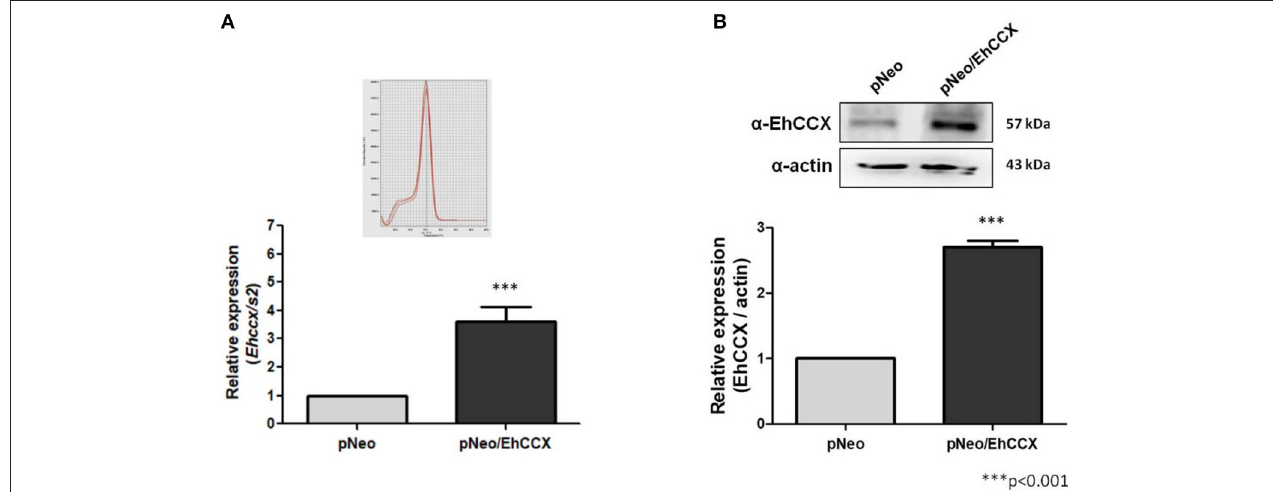
FIGURE 9 | Overexpression of EhCCX. The Ehccx full-length gene was cloned into the pNeo vector and trophozoites were transfected with this construct (pNeo/EhCCX). Trophozoites transfected with the empty vector (pNeo) were used as controls. (A) RNA isolated from trophozoites was used for qRT-PCR assays. As gene normalizer we used the gene coding for the S2 protein of the 40S ribosome subunit. Relative expression was determined using the 2 − 11 CT method. Inset showed the melt curve that demonstrates the specificity of the Ehccx amplification. (B) Western bolt assays using the α -EhCCX antibody. As an internal control, the membranes were probed with an α -actin antibody. The band detected by the α -EhCCX antibody was analyzed by densitometry and the data were normalized to the actin content. The relative expression in pNeo trophozoites was taken as 1. Data are expressed as the mean ± standard error of three independent experiments.